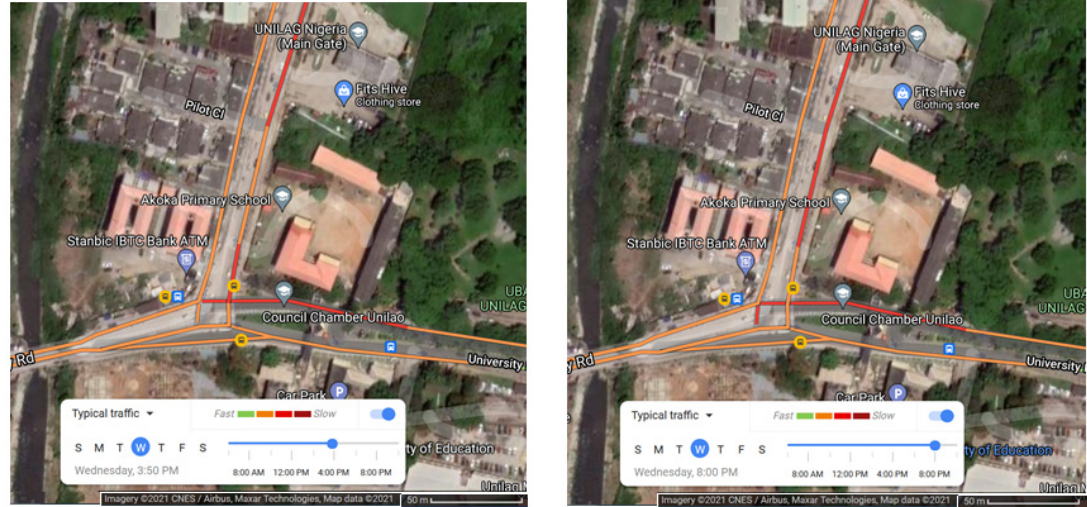
Figure 2. Typical traffic on a Wednesday at 4 p.m. ( left ) and 8 p.m. ( right ) on roads leading to the university gate house. Adapted from Google Maps (accessed on 24 August 2021).